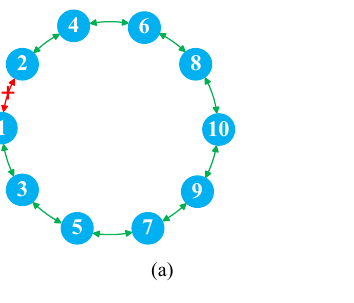
Figure 14. Three communication failure topologies